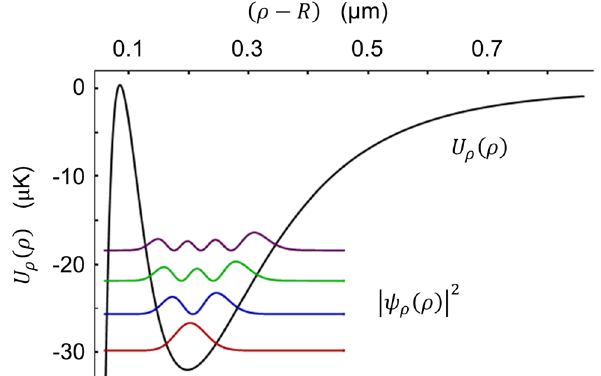
Figure 6. Vibrational states in radial potential. Several lowest vibrational states ψ ρ (ρ) of an atom moving inside the potential U ρ (ρ) along the radial direction. The potential depth is 32 K µ . The vibrational states are separated 2 π 86 kHz. The corresponding Lamb–Dicke parameter is with an approximately equal spacing of � ρ = × 0.23 evaluated to be η ρ =